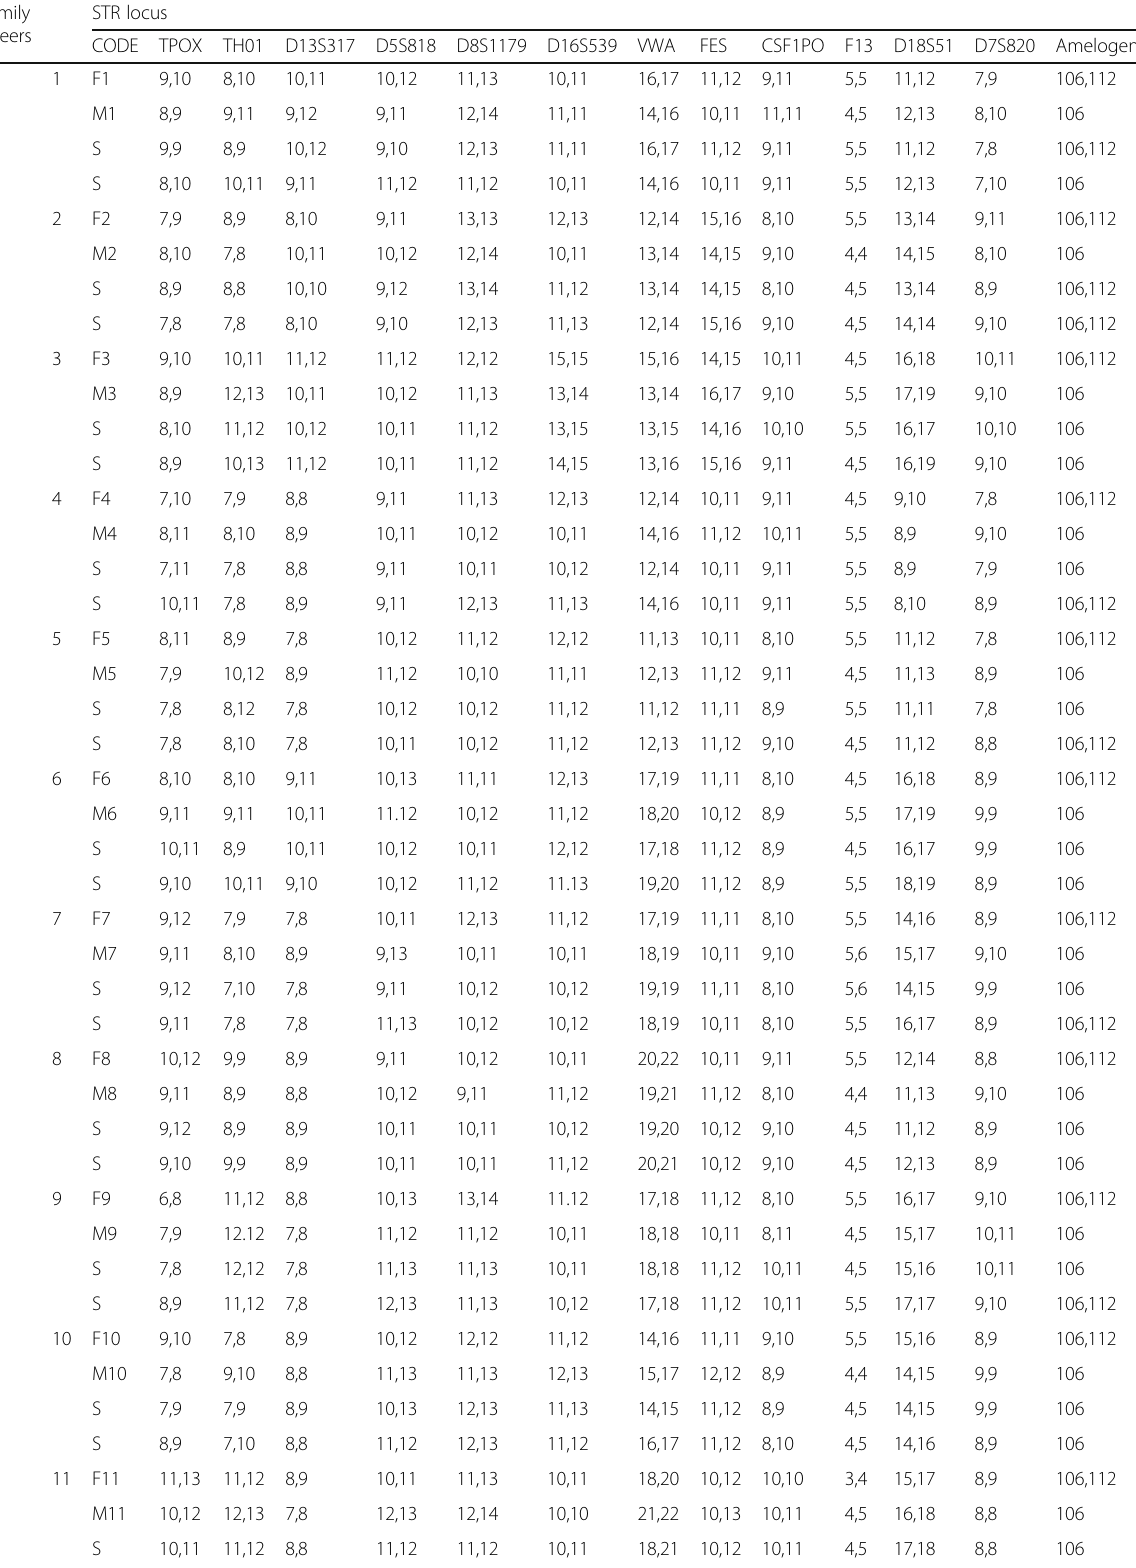
Table 1 Autosomal STR allelic genotype and amelogenin of the 25 full sibling pairs F25 family